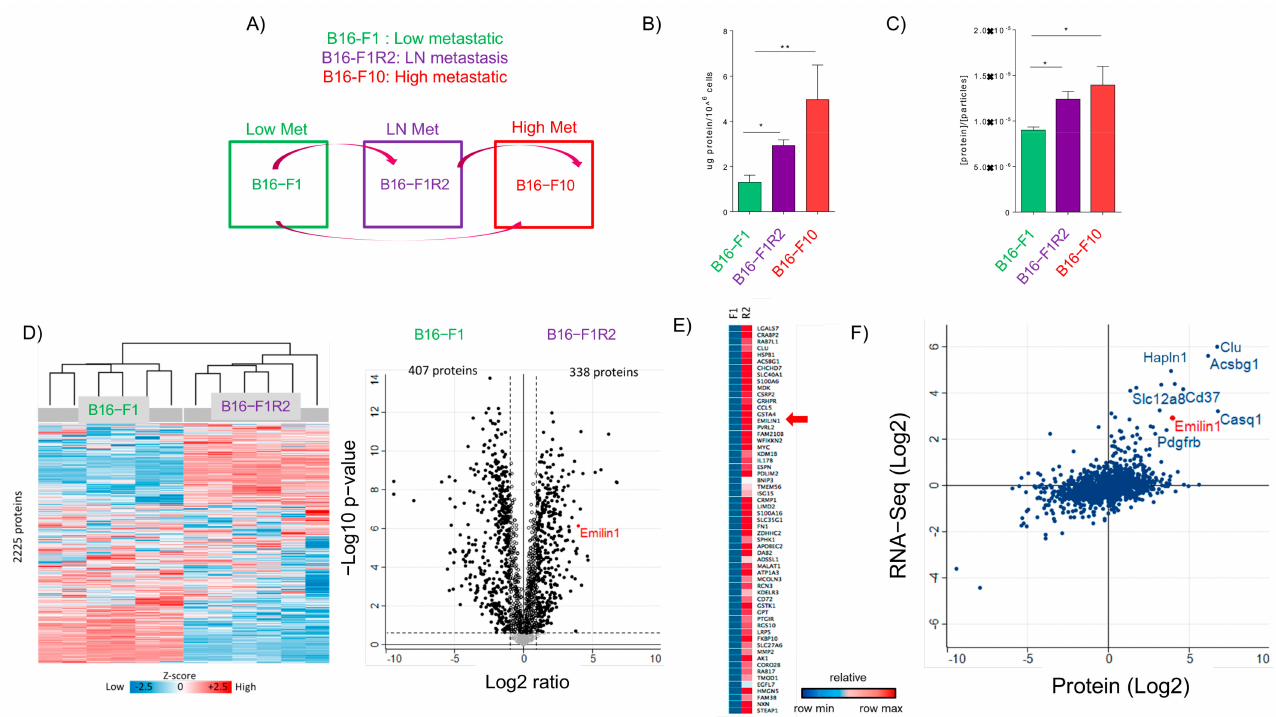
Figure 1. Defining the proteomic signature of sEVs secreted from lymph node metastatic melanoma models. ( A ) Schematic representation of the mouse melanoma models used. ( B ) Analysis of sEV number secretion and ( C ) total protein secreted in sEVs in mouse melanoma cells lines derived from low metastatic model (green), lymph node metastasis (purple) and distal metastasis (dark purple and red). n = 5. * p < 0.05, ** p < 0.01 using Mann Whitney test. ( D ) Unsupervised hierarchical clustering. 2225 proteins were identified in sEVs derived from B16-F1 and B16-F1R2 cell lines. To the right, a volcano plot showing the differentially expressed proteins (Student’s t -test, p < 0.05). Black circles represent proteins above the fold change cutoff. ( E ) Heatmap of genes differentially expressed in B16-F1R2 compared to B16-F1. As noted by the arrow, EMILIN-1 is over-expressed in both cell lines. ( F ) Correlation of proteomic and transcriptomic data to define the main genes overexpressed and proteins hyper-secreted in sEVs from B16-F1R2 compared to B16-F1 cell